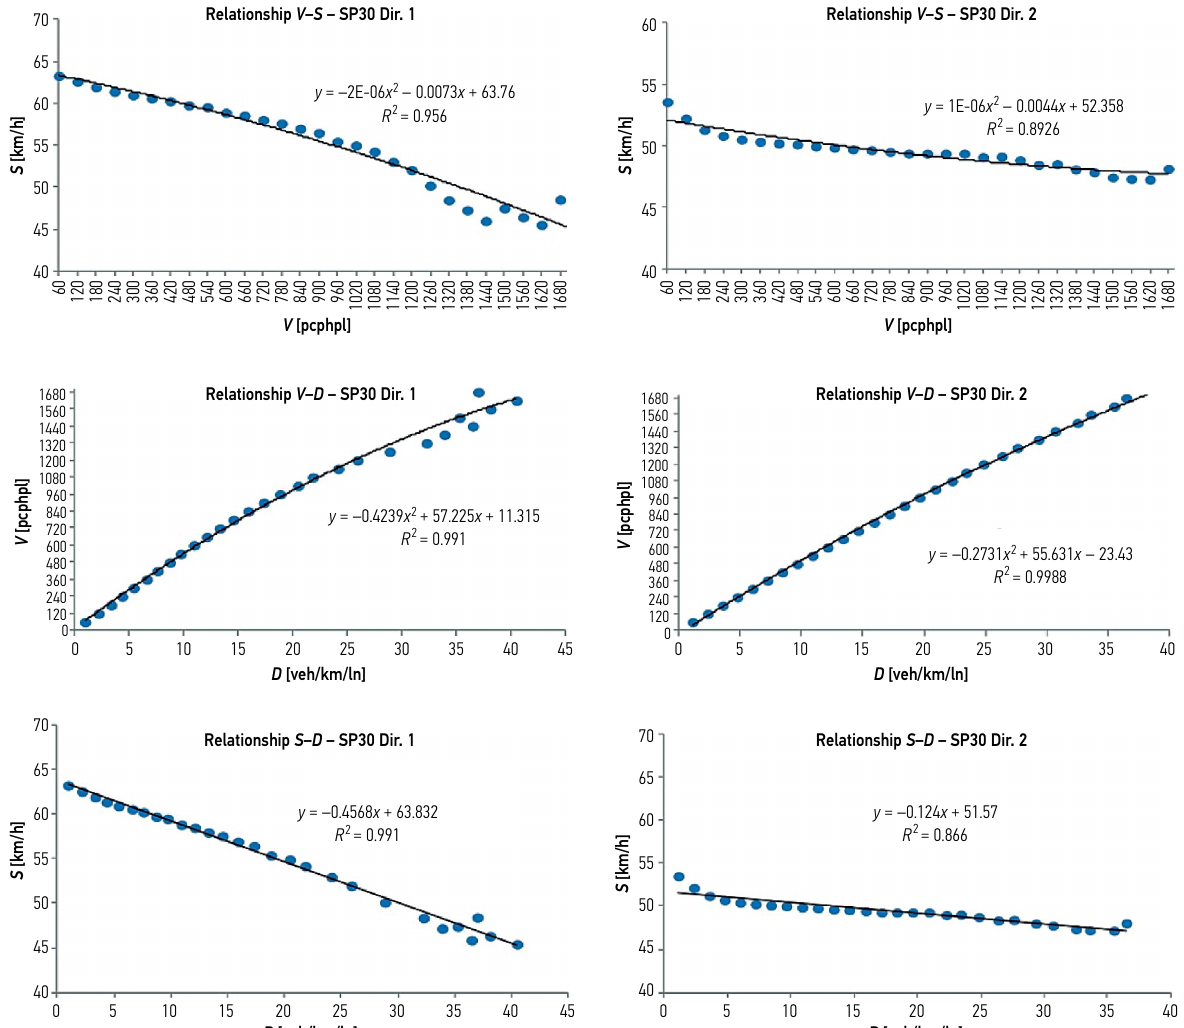
Fig. 5. Relationship between S , V and D for SP30